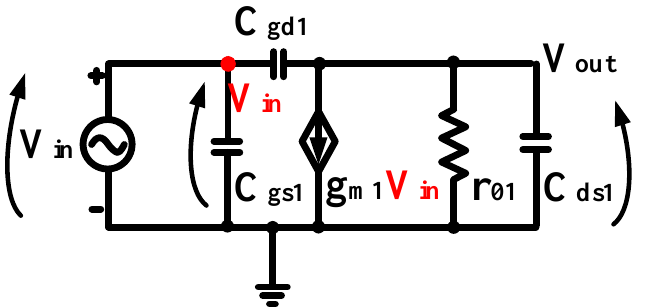
Figure A2. Small-signal equivalent circuit without asymmetric capacitor C x . According to Kirchhoff’s current law (KCL) and Kirchhoff’s voltage law (KVL), it can